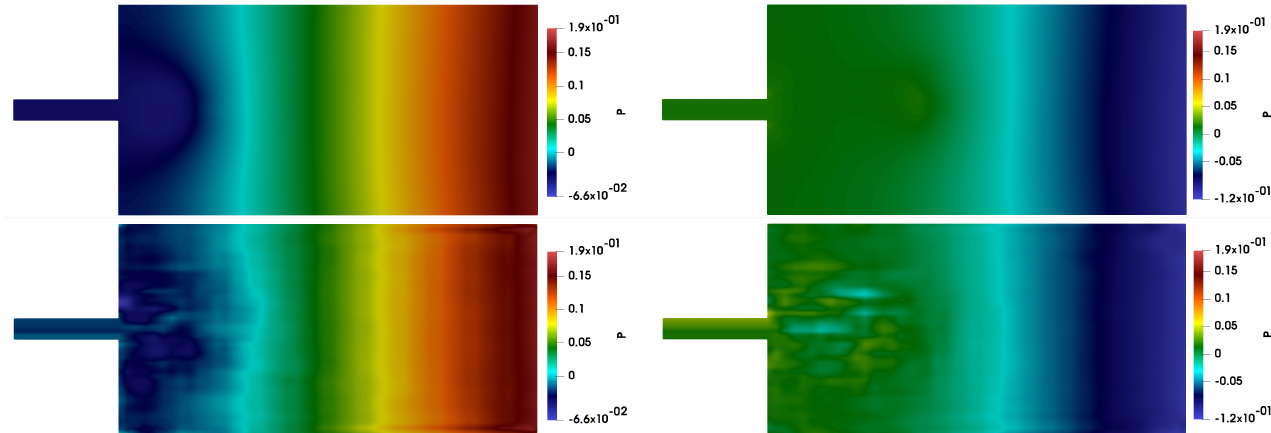
Figure 12. (Classical VAE) On the top, the high-fidelity pressure of the velocity fields for the two time steps 499 and 998. On the bottom, the decoder outputs for the two time steps 499 and 998 at the final 4000-th epoch of the training phase.